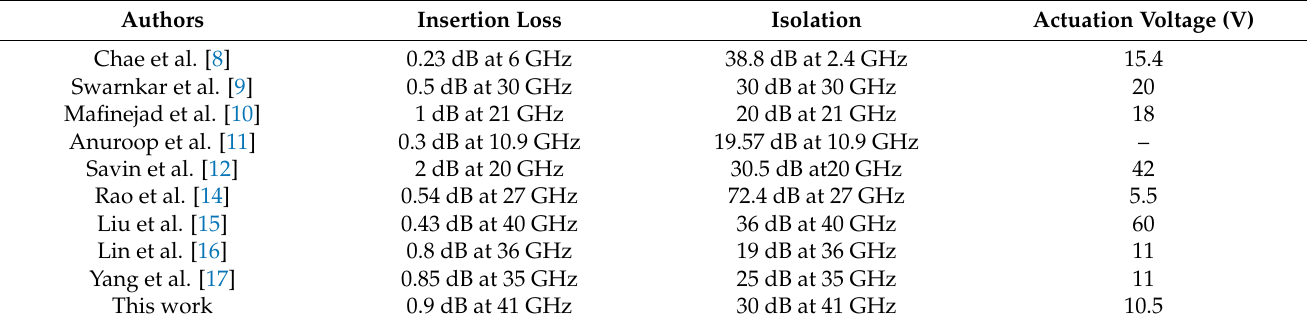
Table 1. Performances for various radio frequency microelectromechanical system